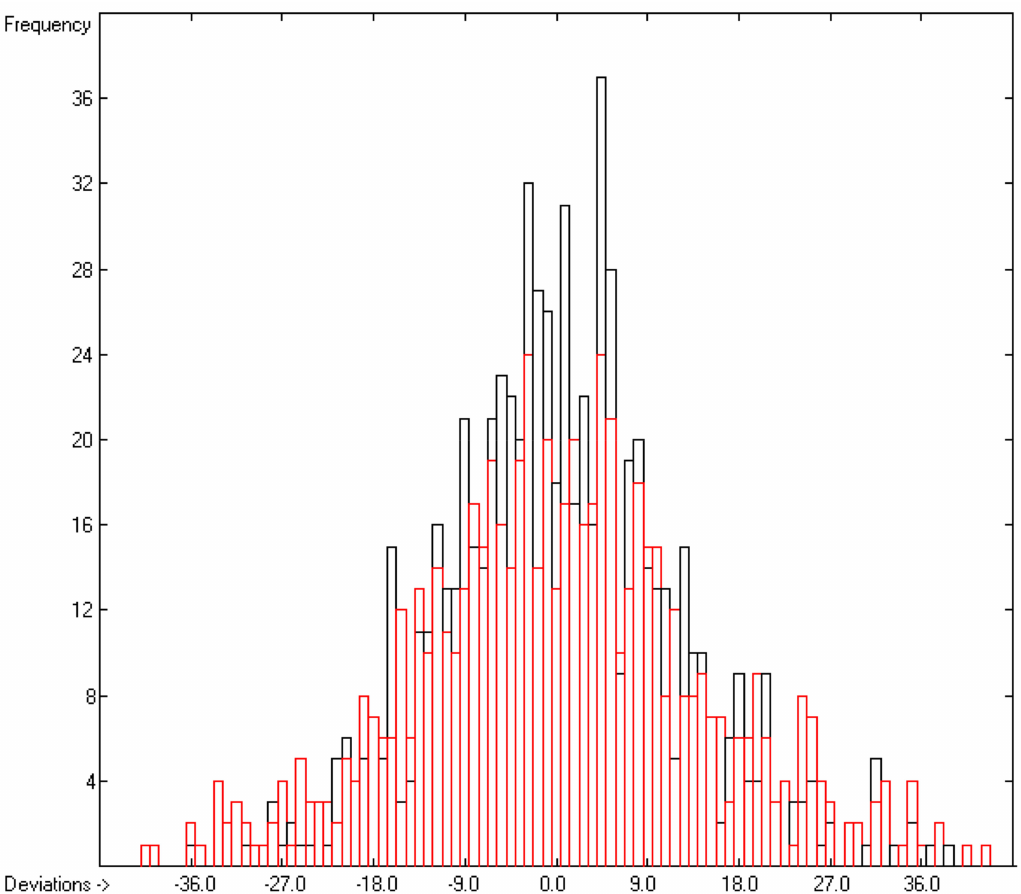
Figure 5. Histogram of the solid heat-capacity data. The deviations are in J / mol / K. The cross-validation data are superimposed as red bars. ( s = ± 14.23; Experimental value range: 78.7–1129 J /